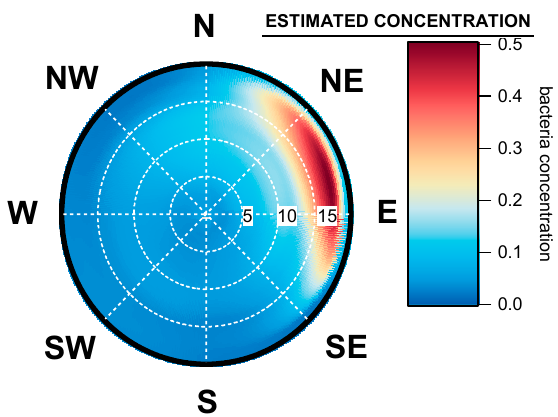
Figure 7. Main geographical origin of bacterial concentration impacting Saclay observatory. The dotted white circles represent the wind speed scale in kilometer per hour (km/h), and the color grid represents the origin of the highest estimated concentration for any wind speed and wind direction.